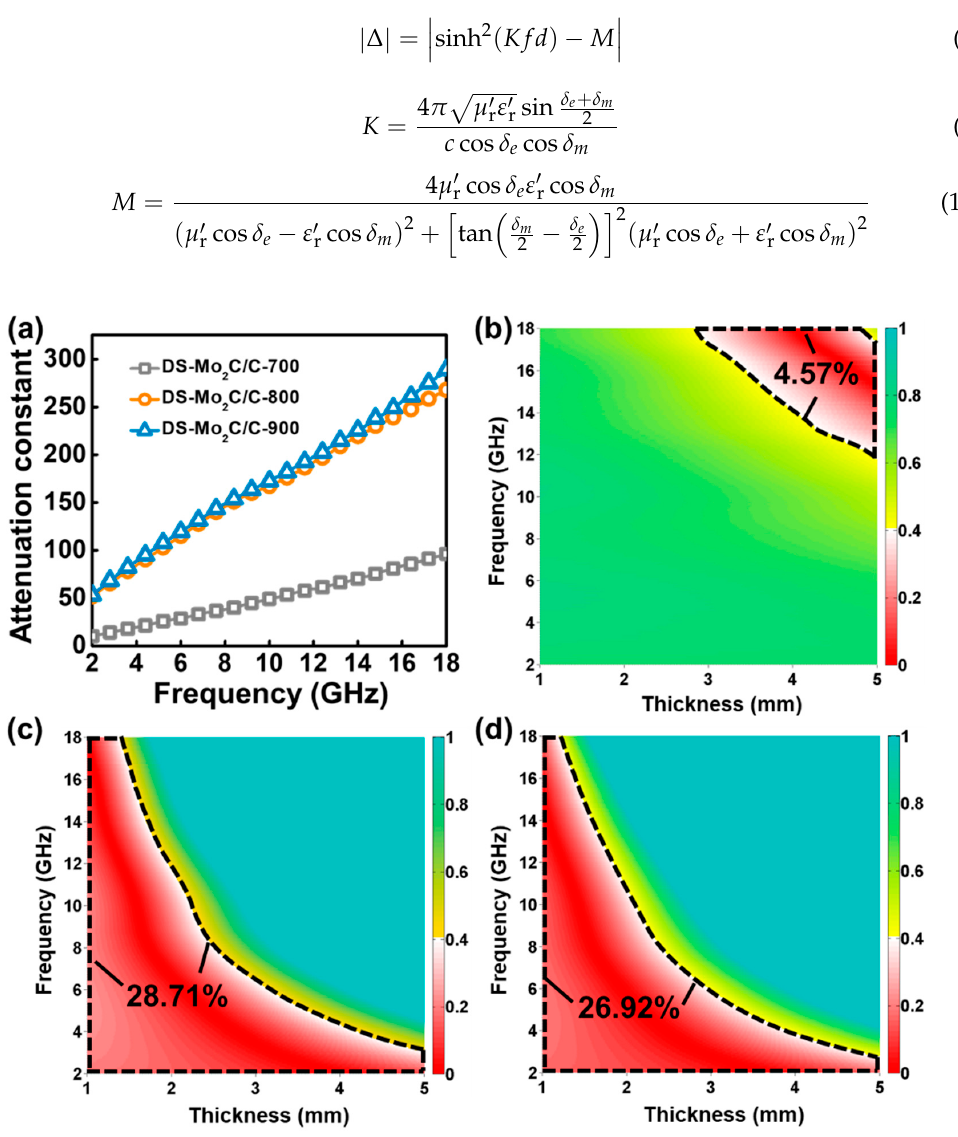
Figure 7. The attenuation constant for DS − Mo 2 C/C ( a ); calculated delta value maps of 700 ( b ), DS-Mo 2 C/C-800 ( c ), and DS-Mo 2 C/C-900 ( d